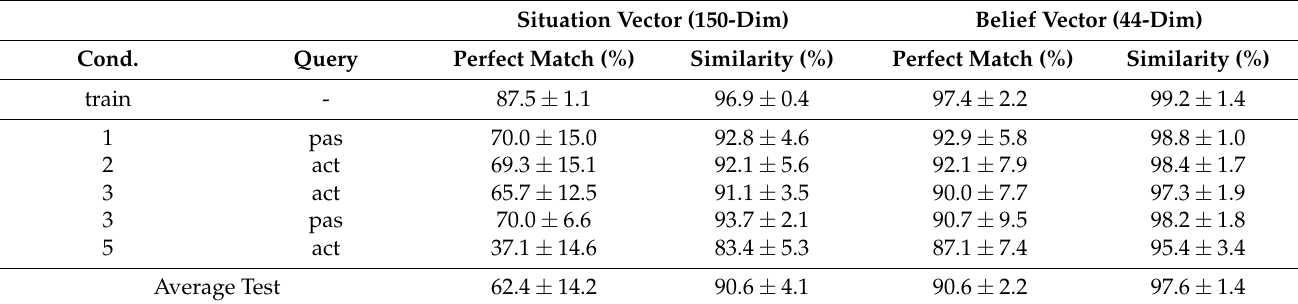
Table 5. Similarity scores for each test condition ± their standard deviation. Situation Vector (150-Dim) Belief Vector